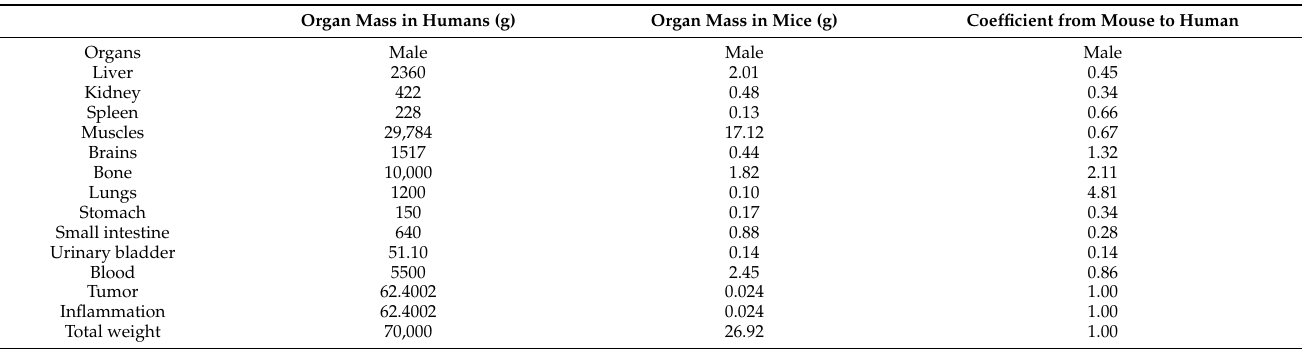
Table 4. Conversion of cumulated activity from mice to humans. Mice Human Time